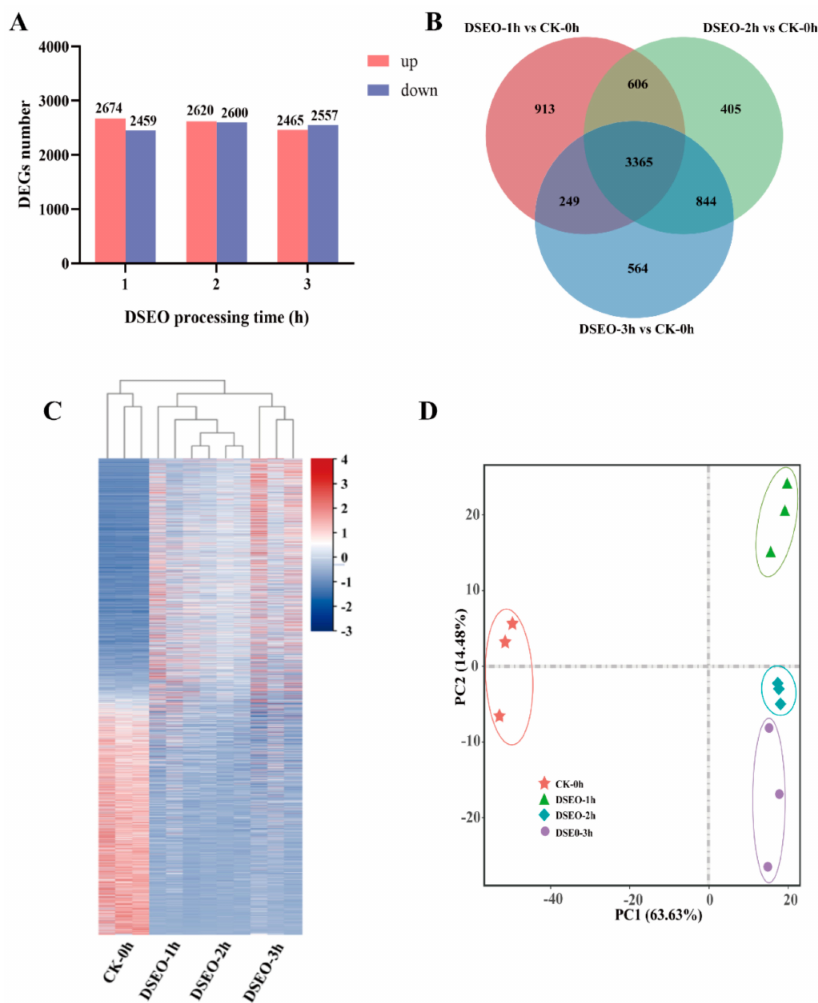
Figure 5. Distribution of DEGs in DSEO-treated and control N. parvum . ( A ) Histogram showing the number of DEGs in N. parvum after different treatments. ( B ) Venn diagram showing the overlap of DEGs from the 1 h, 2 h, and 3 h datasets. ( C ) Heatmap of DEGs in N. parvum before and after DSEO treatment. Each row represents the expression pattern of one gene, and each column corresponds to one sample. ( D ) Principal component analysis (PCA) of transcriptomics data. (n = 3). “CK” represents